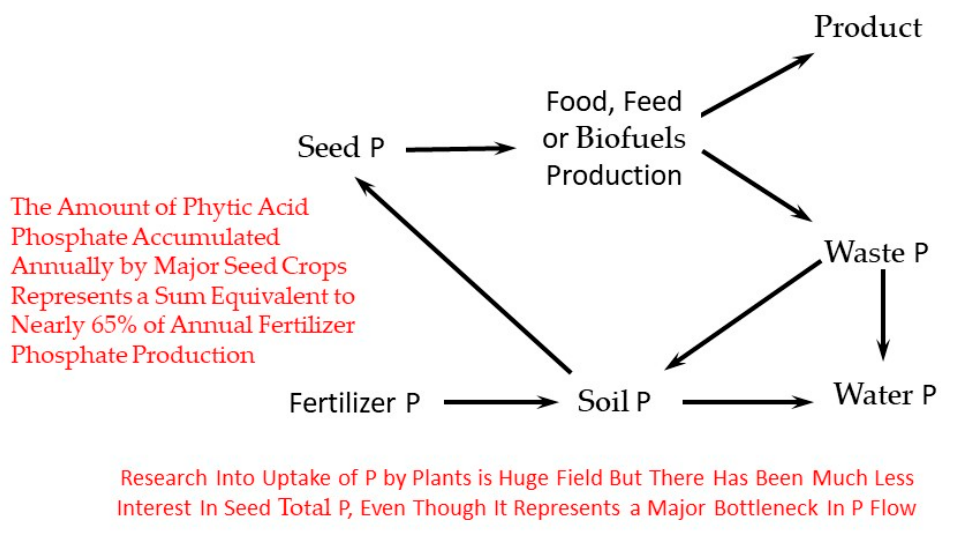
Figure 2. Phosphorus (P) flow through the world-wide agricultural ecosystem.